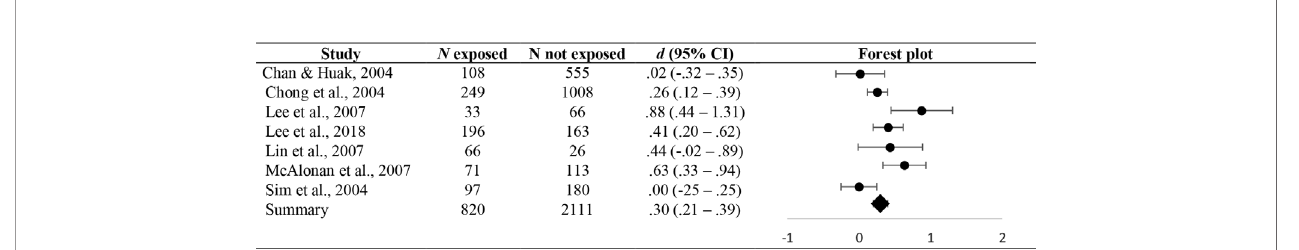
FIGURE 3 | Forest plot of PTSD symptoms.